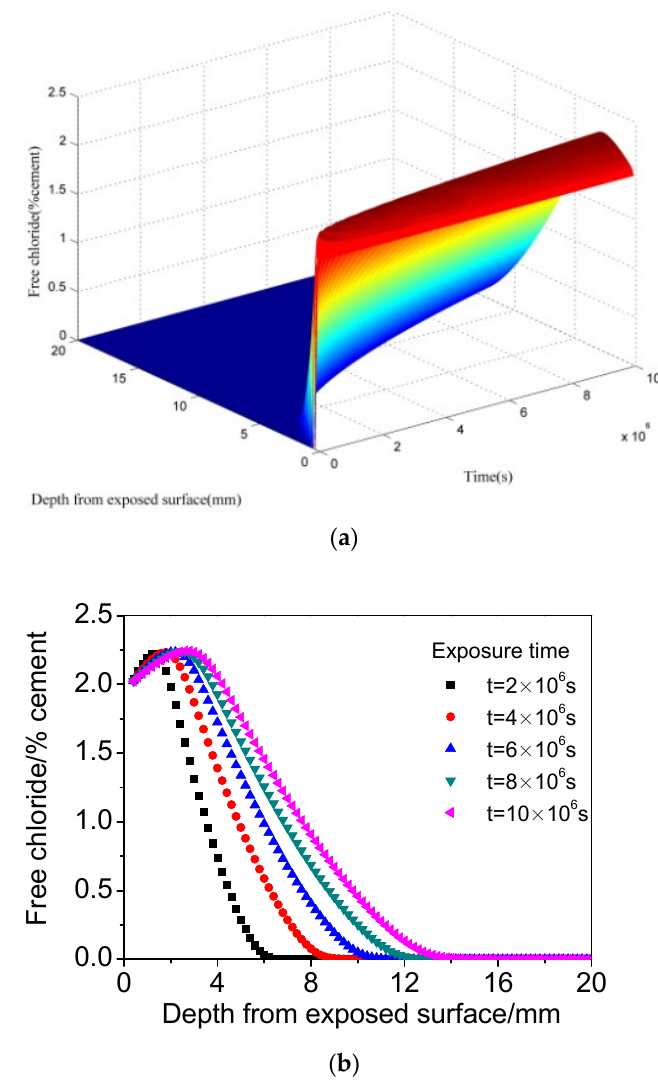
Figure 3. The calculated chloride distribution of concrete subjected to cyclic wetting–drying condi- tions when the CO 2 concentration is 0.04%. ( a ) Three dimensions. ( b ) Two dimensions.